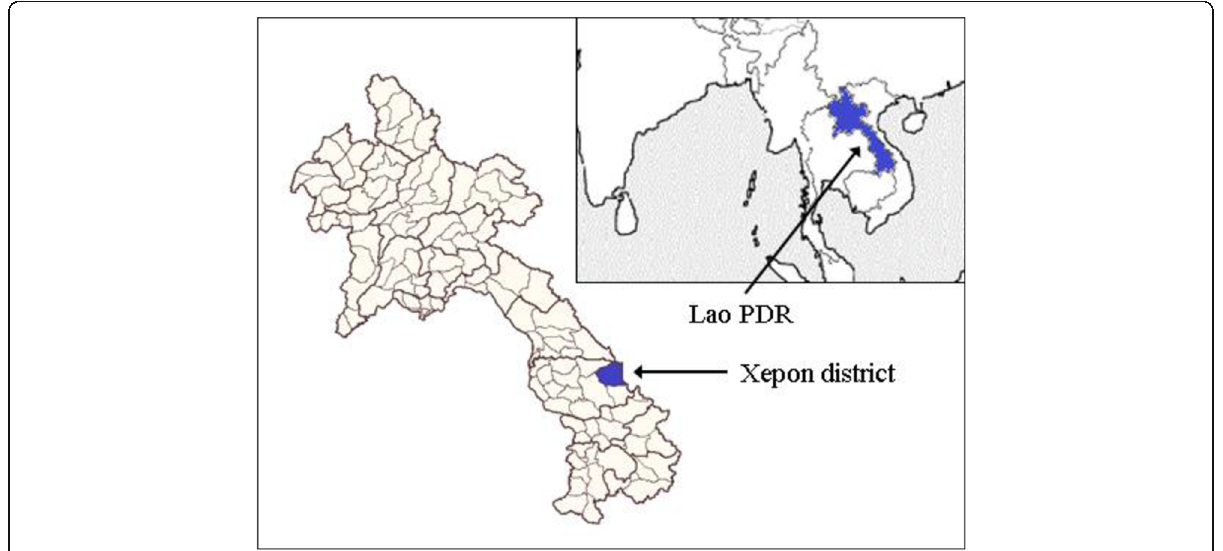
Fig. 1 The location of the Lao PDR and Xepon